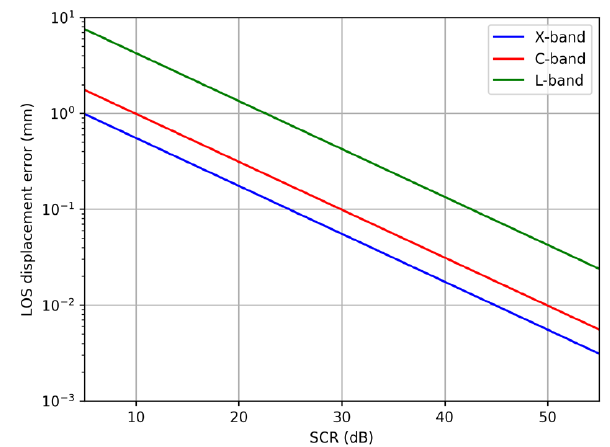
Figure 3. LOS displacement error as a function of SCR for the radar frequencies of Figure 3